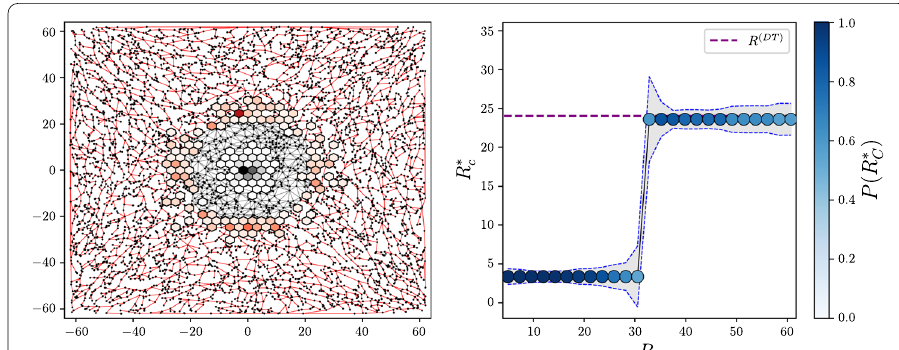
Fig. 3 Spatial behavior of congestion nodes for the random planar models introduced in “A model for center‑periphery entanglement” section with N = 6000 , L = 60 , and R ( DT ) = 24 . In the left panel, the resulting network configuration, with MST and DT edges painted in red and black, respectively. Hexagonal bins provide information about the occurrence of congestion nodes in space, and their colors show the related frequency in proportion to the intensity. In the right panel, we present the dependence of the congestion radius R c on the patch radial size R p , i.e., the radius of the circle centered in the middle of the network, that is used to define the considered subgraph within this radius. The congestion radius range is divided in bins, and each point is located at the statistical mode R ∗ c obtained with the distribution of R c after 100 realizations. The color of the circular markers shows the probability of that value over the experimental R c distribution. Shadow areas represent the variance of the different realizations of R c values with respect to the bin average